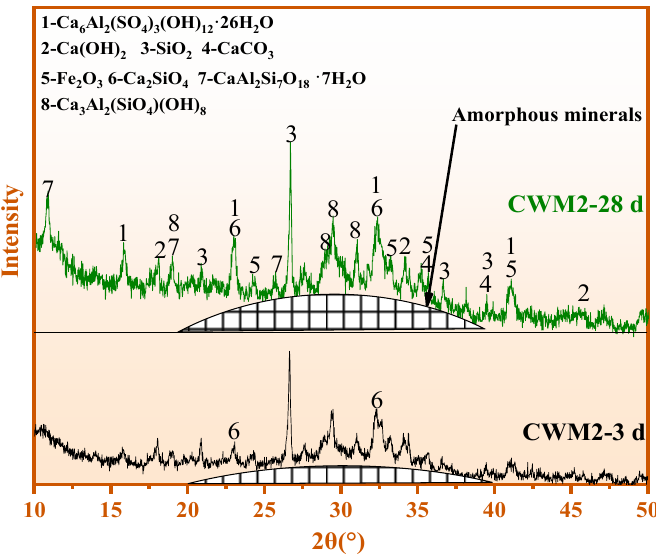
Figure 9. XRD of CWM2 at 3 days and 28 days.